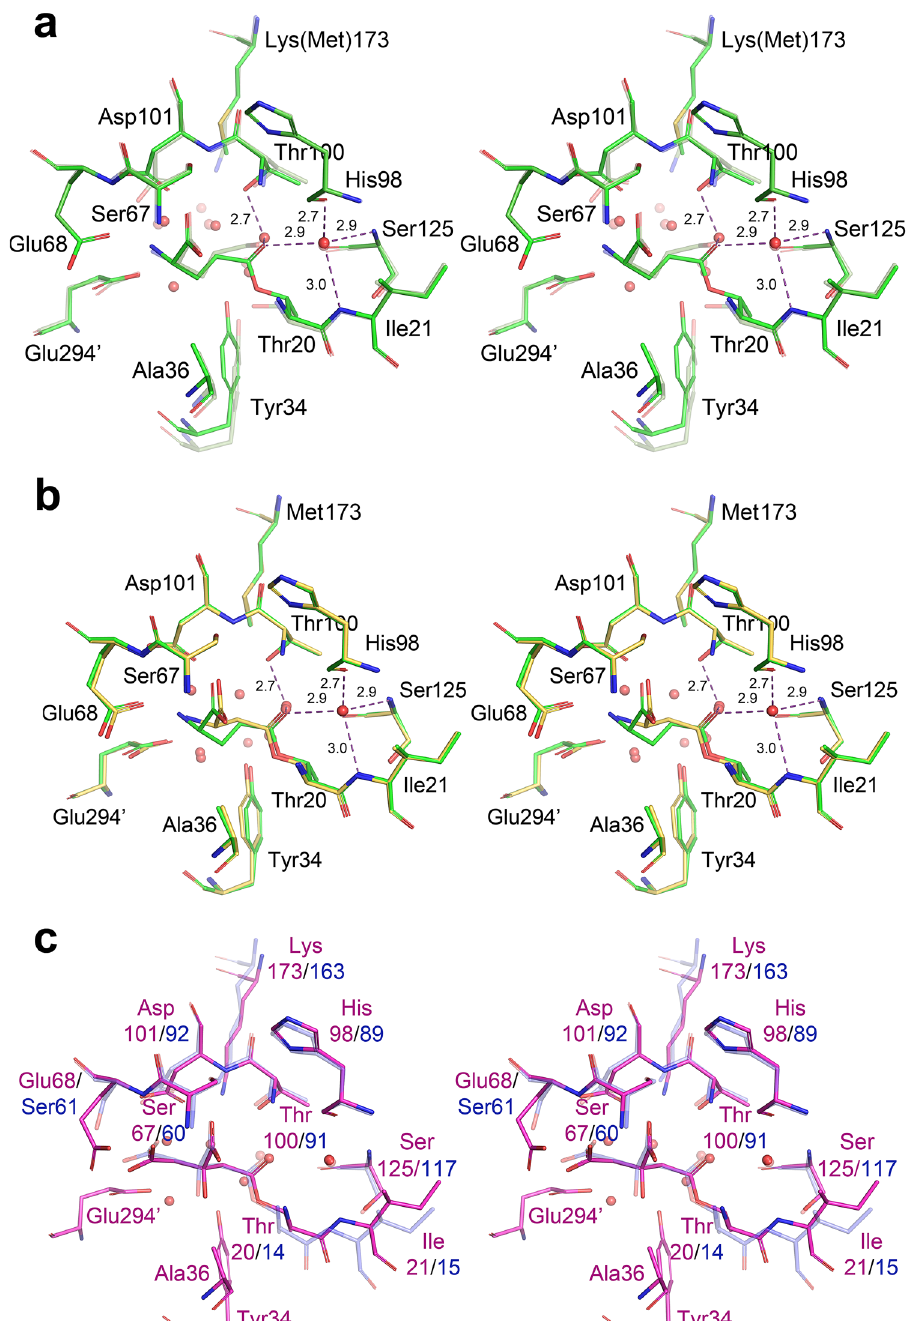
Figure 5. Active site of PGA with covalently-bound ligands and the non-covalent complex with L-glutamic acid. ( a ) Superposition of a covalent complex of PGA(K173M) and L-Glu (green) with non-covalent complex between PGA(wt) and L-Glu (semi-transparent gray). H-bonds engaging two important water molecules are indicated by dashed lines and the associated distances are shown. ( b ) Near-perfect structural equivalence of the covalent complexes of PGA(K173M) with L-Asp (yellow) or L-Glu (green). ( c ) Superposition of covalent complexes between PGA(wt) (magenta) and EcAI(wt) (6nxd) (semi-transparent blue) with citrate. Most of ASFL could not be modeled in the EcAI(wt) complex. Despite of low amino acid sequence conservation and different substrate specificities of the two enzymes, binding of citrate to their active sites is almost identical. Figure was prepared with the licensed programs PyMol ver. 2.3.2, (Schrodinger LLC) and Adobe Photoshop CC